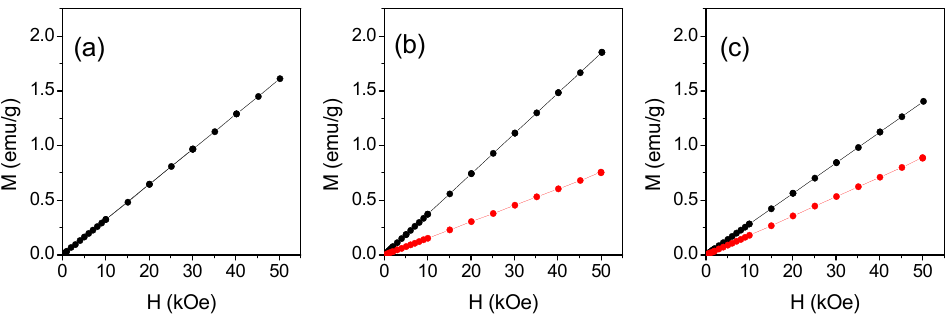
Figure 2. Magnetization (M) vs. magnetic field (H) plots measured at T = 300 K on MP ( a ), MDE2 ( b ), and MDB ( c ) powders as samples freshly prepared (black line) or aged 13 ( b ) and 3 ( c ) days (red